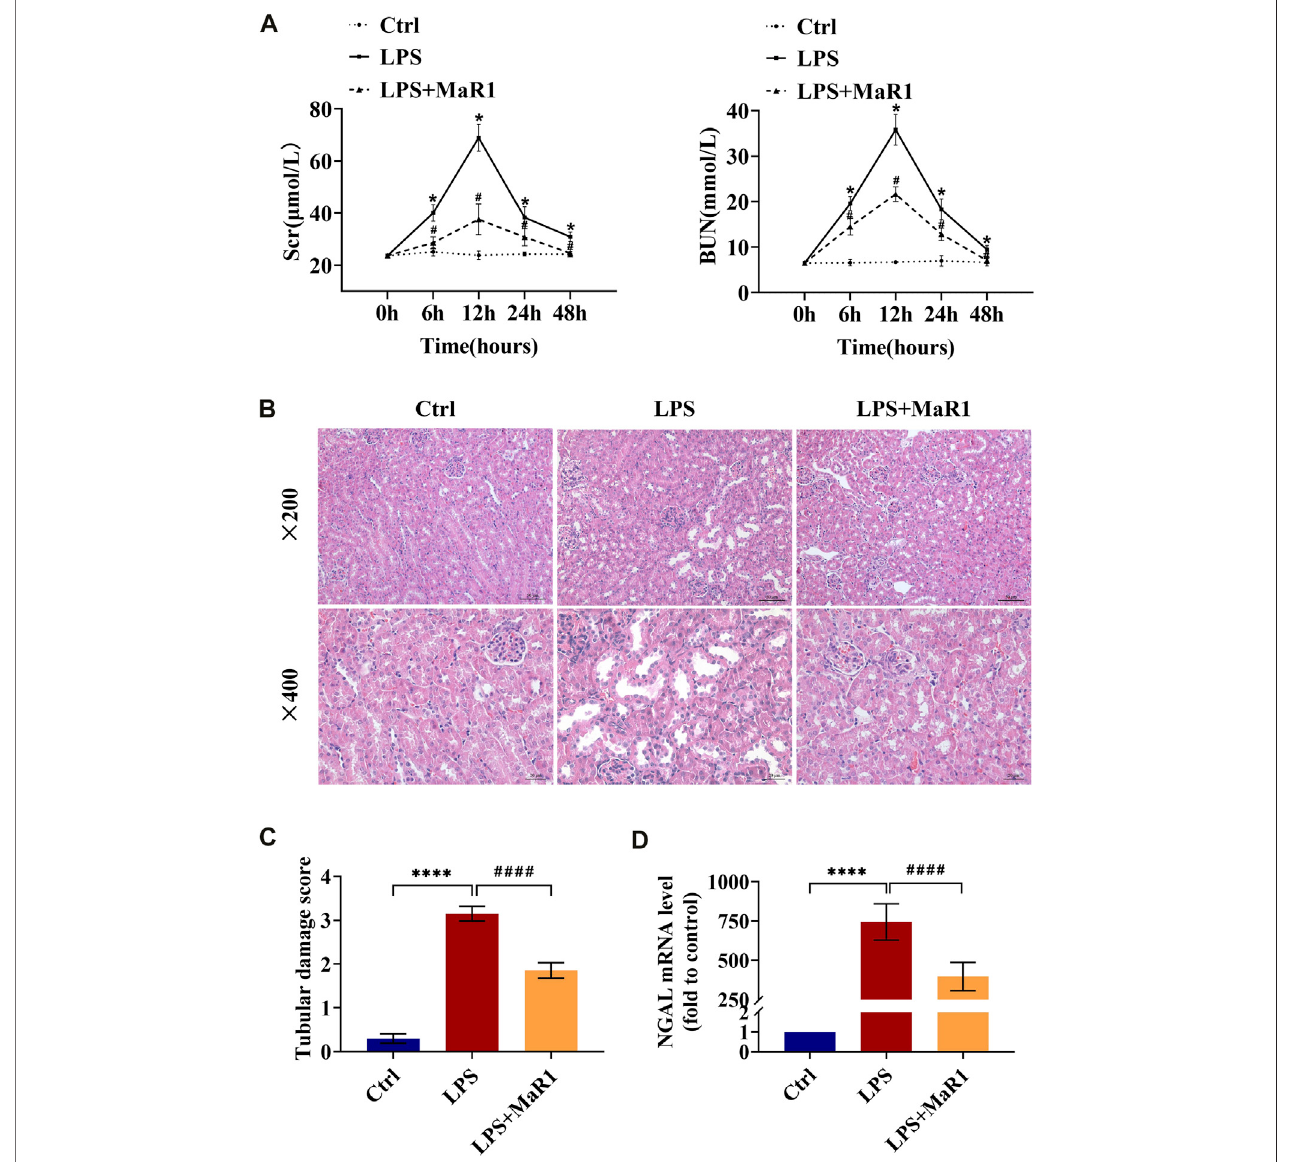
FIGURE 1 | MaR1 alleviated renal injury in lipopolysaccharide (LPS)-induced S-AKI mice. (A) Serum creatinine and blood urea nitrogen levels at 0, 6, 12, 24, and 48 h after LPS intraperitoneal injection in each group of mice. (B) Representative HE staining images of kidney tissues were collected (scale bars (cid:2) 50 and 20 μ m) (time point: 12 h). (C) Pathological tubular damage score. (D) Gene expression of neutrophil gelatinase-associated lipocalin in renal tissues were quantitated using qRT-PCR (time point: 12 h). Data are presented as mean ± SD, n (cid:2) 5. * p < 0.05, ** p < 0.01, *** p < 0.001, **** p < 0.0001; # p < 0.05, ## p < 0.01, ### p < 0.001, #### p < 0.0001 vs . LPS